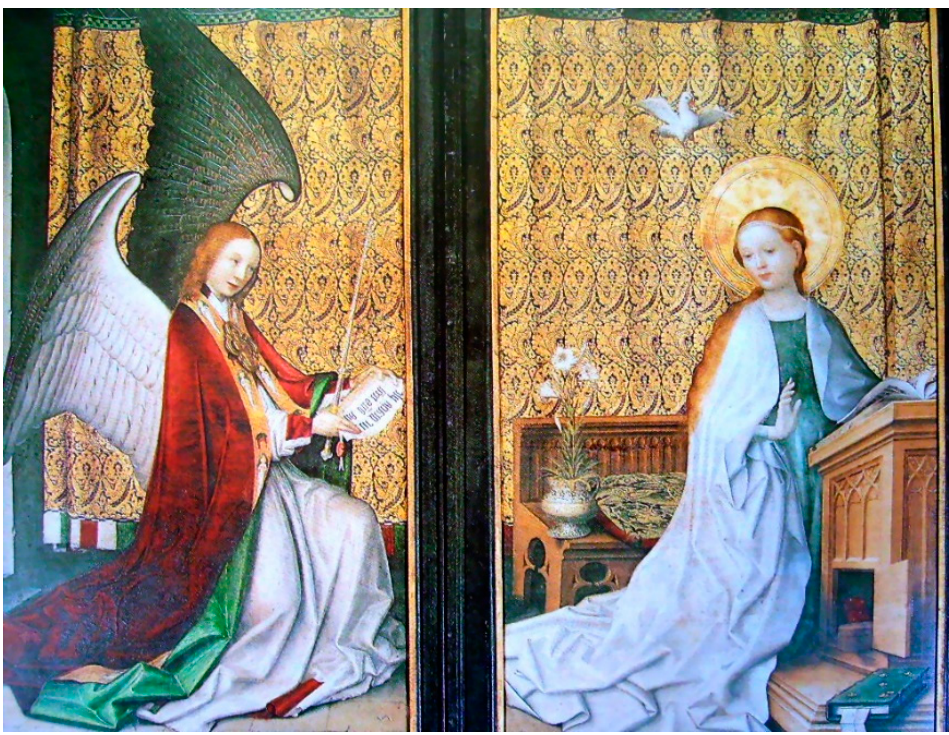
Figure 6. Stefan Lochner, The Annunciation , two panels of the closed Magi Altarpiece , Cologne cathedral, 1440.